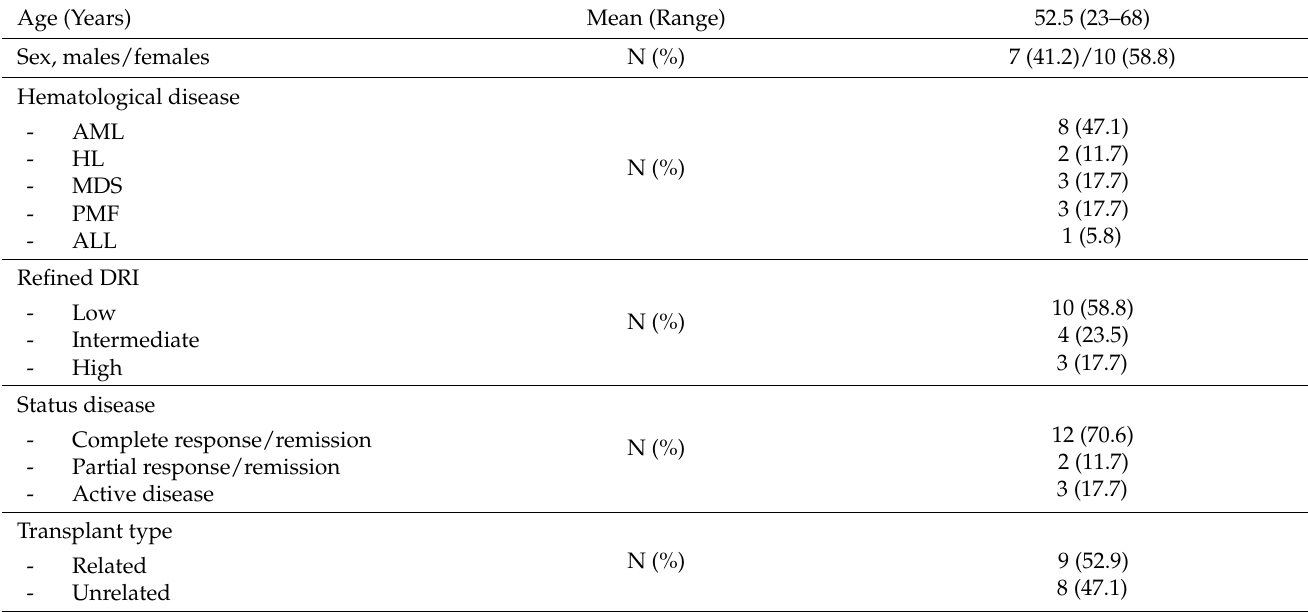
Table 2. Baseline and transplant characteristics of patients